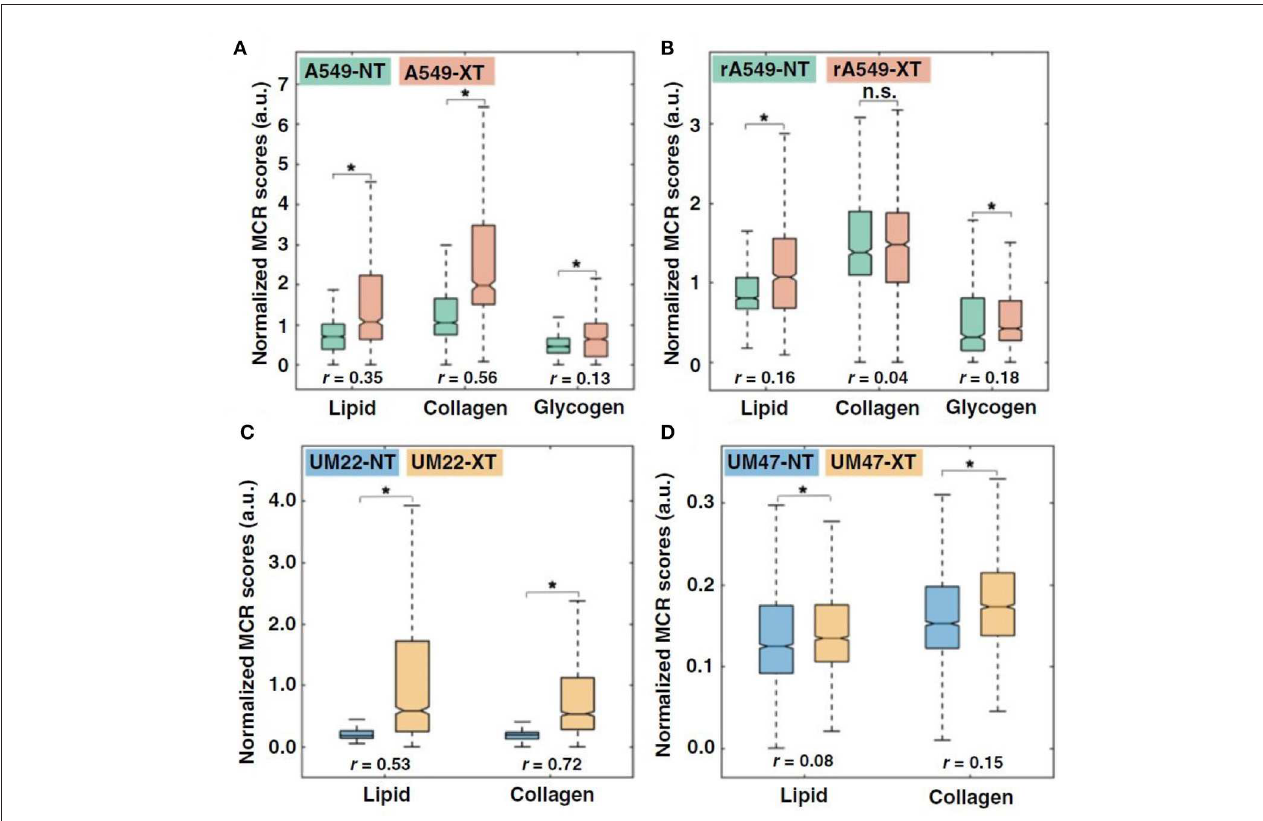
FIGURE 5 | Quantitative MCR-ALS analysis of Raman spectra. (A,B) , Boxplots of normalized scores of lipid-rich, collagen-rich, and glycogen-rich MCR-ALS loadings showing radiation-induced differences in sensitive lung tumors (A549-NT vs. A549-XT) (NT: not treated, XT: X-ray treated) (A) and radiation-induced differences in resistant lung tumors (rA549-NT vs. rA549-XT) (B) . (C,D) , Boxplots of normalized scores of lipid-rich and collagen-rich MCR-ALS loadings showing radiation-induced differences in sensitive head and neck tumors (UM-SCC-22B-NT vs. UM-SCC-22B-XT) (C) and radiation-induced differences in resistant head and neck tumors (UM-SCC-47-NT vs. UM-SCC-47-XT) (D) . The effect size ( r ), characterizing magnitude of differences between groups, is provided for each comparison. * p < 0.001. Adapted with permission from Paidi et al. (